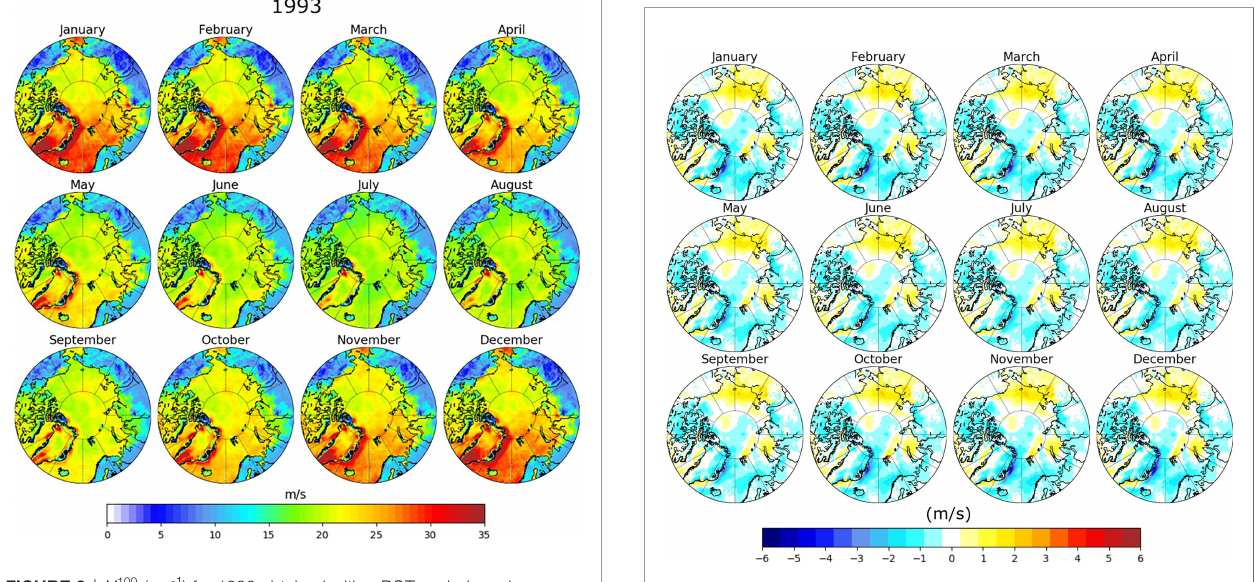
FIGURE 10 | Monthly differences in U 100 10 between estimates for 2018 and